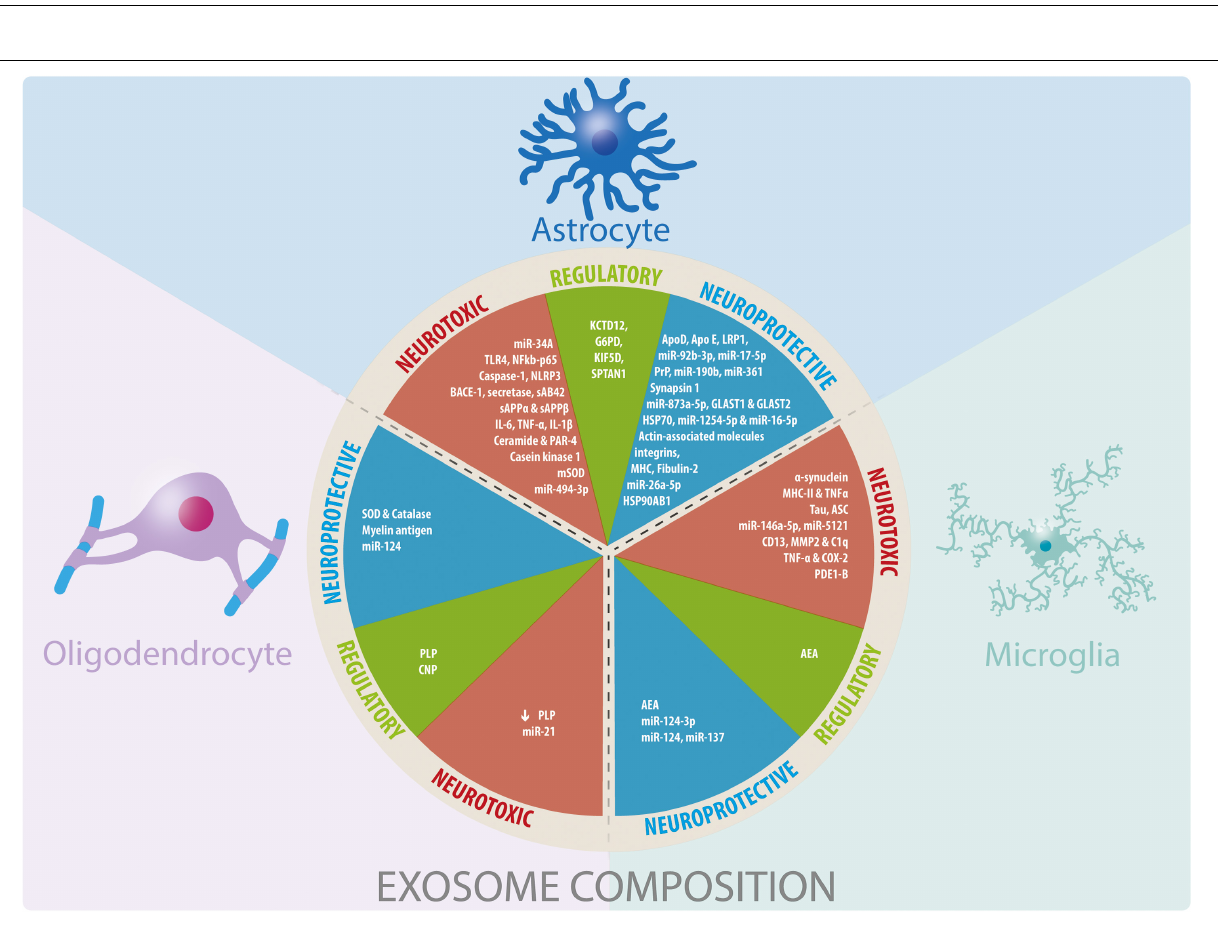
Frontiers in Cellular Neuroscience |